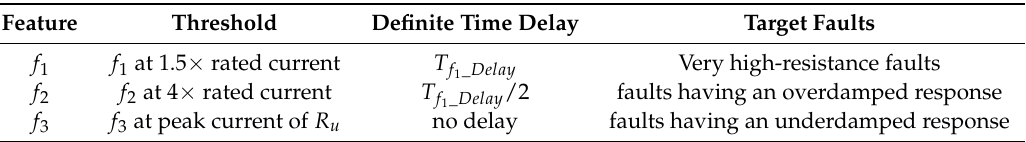
Table 1. Threshold